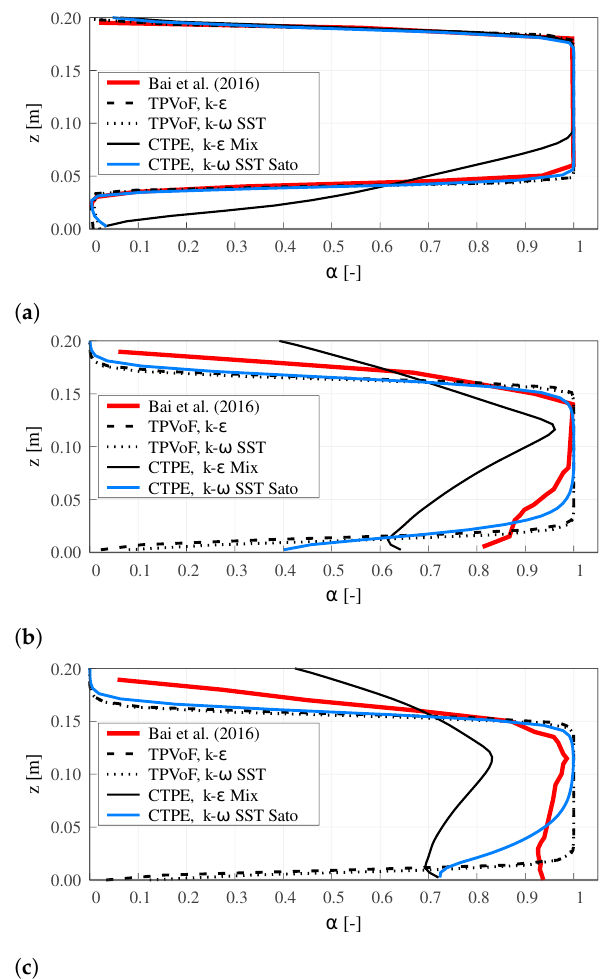
Figure 6. Water volume fraction vertical profile at x = { 0.2,0.7,1.0 } m; R m = 30. ( a ) x = 0.2 m. ( b ) x = 0.7 m. ( c ) x = 1.0